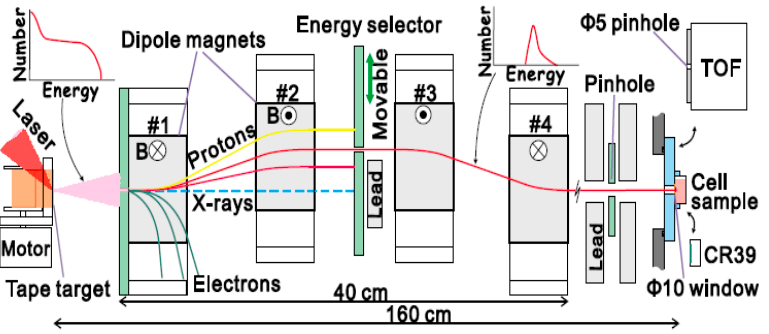
Figure 15. A particle selector system originally designed by Ma et al. [70]. This particular diagram of similar design is presented by kind permission of Yogo et al. [25]. In other variants of this system further focusing quadrupoles can be placed at the output [73]. Reproduced from [25]. Copyright 2011, AIP Publishing